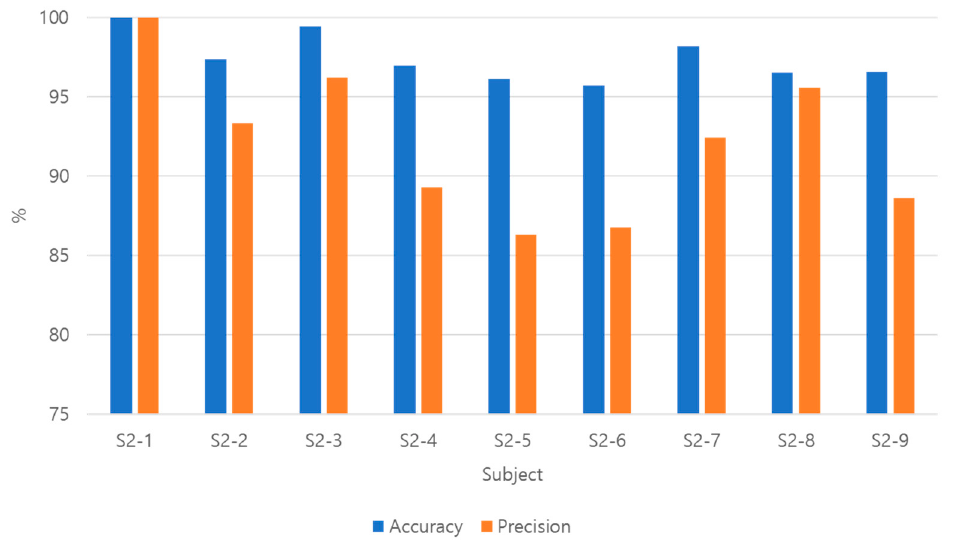
Figure 16. Accuracy and precision for each subject.